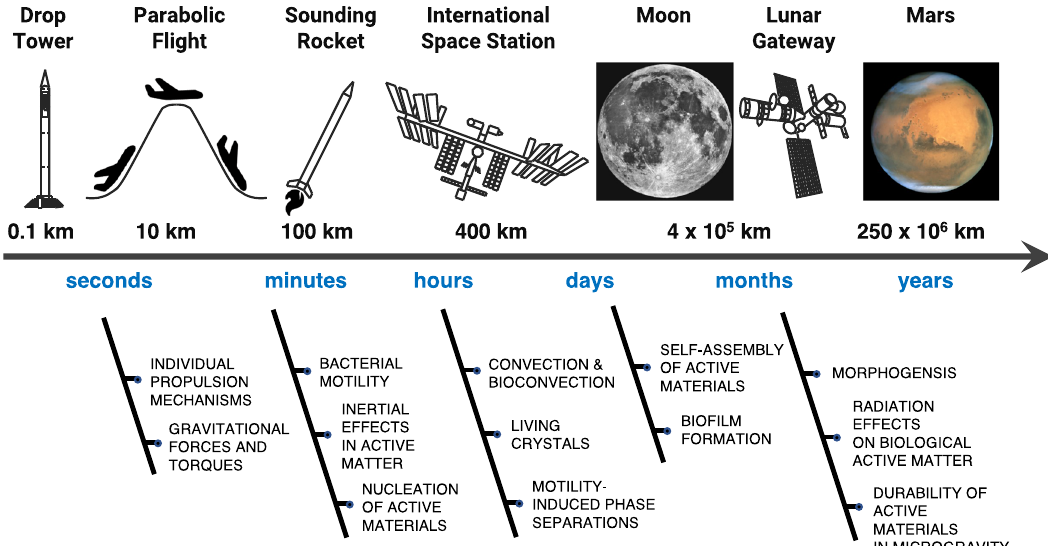
Fig. 4 The future of space exploration for active matter. In the near future (<3 years), we can expect an increase in active matter experiments on the International Space Station (ISS) in low Earth orbit (LEO) based on using or adapting existing instrumentation for soft matter studies in microgravity. The main advantage of running active matter experiments on the ISS is the possibility of studying these systems under microgravity conditions for up to several hours. In the mid (5 – 10 years) and long term (>10 years), fi tting this instrumentation on Moon, Mars and Beyond-Low-Earth-Orbit (BLEO) missions (e.g., on the Lunar Gateway) will enable testing active matter for the future of space exploration and colonisation on even longer time scales (up to a few years or longer). Moon picture credit: ESA/Hubble; use permitted under a CC-BY 4.0 licence. Mars picture credit: ESA/Hubble; use permitted under a CC-BY 4.0